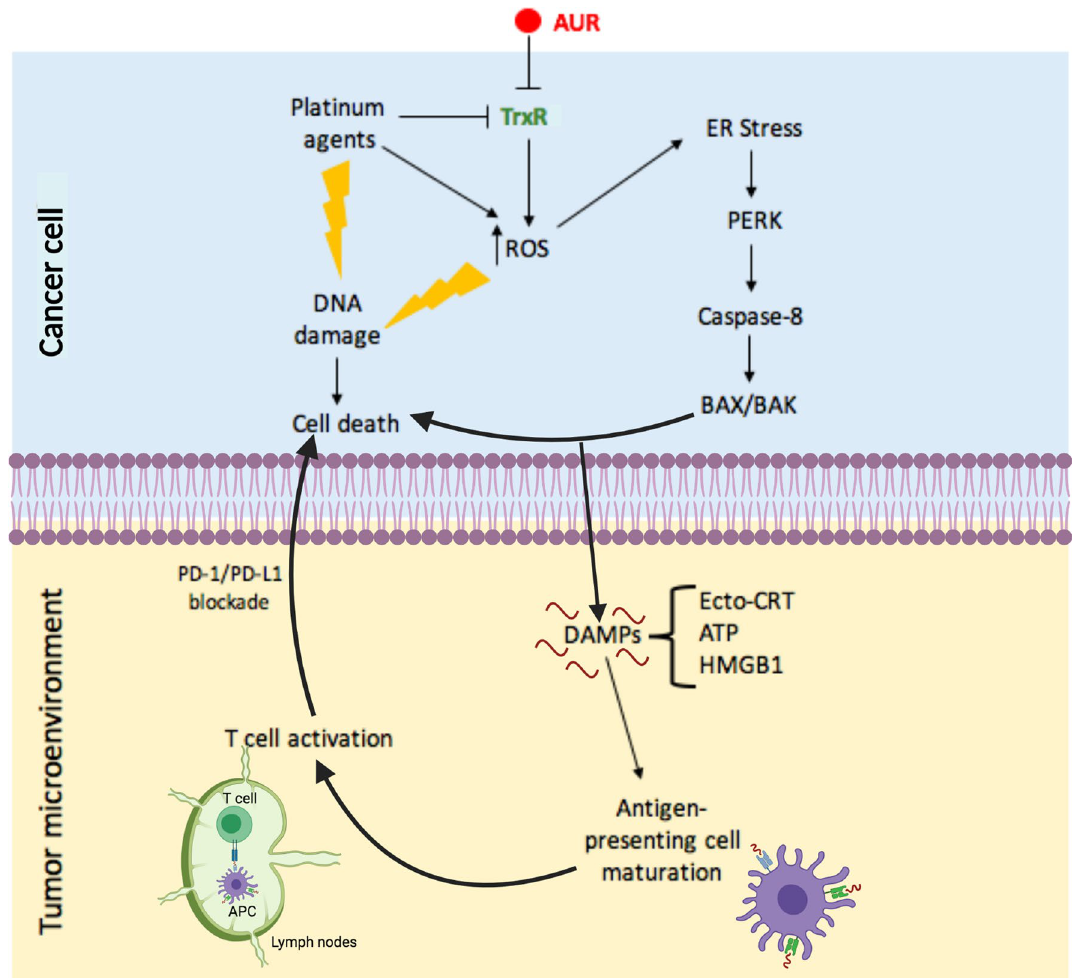
Fig. 3 Targeting cancer cells with a combination of auranofin (AUR) and a platinum agent in the context of the tumor microenvironment. AUR and platinum agents inhibit the function of TrxR, inducing an overproduction of reactive oxygen species (ROS), mitochondrial perme- ability, and DNA damage, resulting in cancer cell death. Accumulation of intracellular ROS induces ER stress, activation of PERK and cas- pase-8, and the upregulation of pro-apoptotic proteins BAX and BAK, further potentiating cell death. This pathway triggers the release of danger or damage associated molecular patterns (DAMPs) such as calreticulin (ecto-CRT), high mobility group box 1 (HMGB1) protein and ATP into the tumor microenvironment where they collectively activate antigen presenting cells (APCs). Mature APCs migrate into the lymph nodes and present tumor antigens to immature T cells, which develop into CD8+T cells with anti-cancer cytotoxic activity. The inhibition of the interaction between PD-1 on T cells and PD-L1 on cancer cells prevents the neutralization of T cells by cancer cells, maintaining T cell cytotoxicity and favoring tumor cell death. This release of DAMPs into the tumor microenvironment via ER stress and the consequent activa- tion of T cells is known as immunogenic cell death or